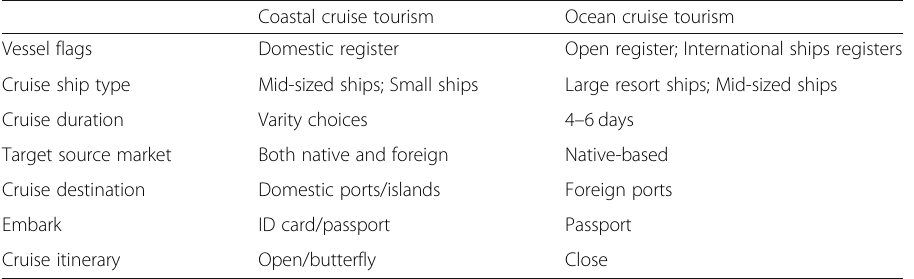
Table 1 The major differences between coastal and ocean cruise